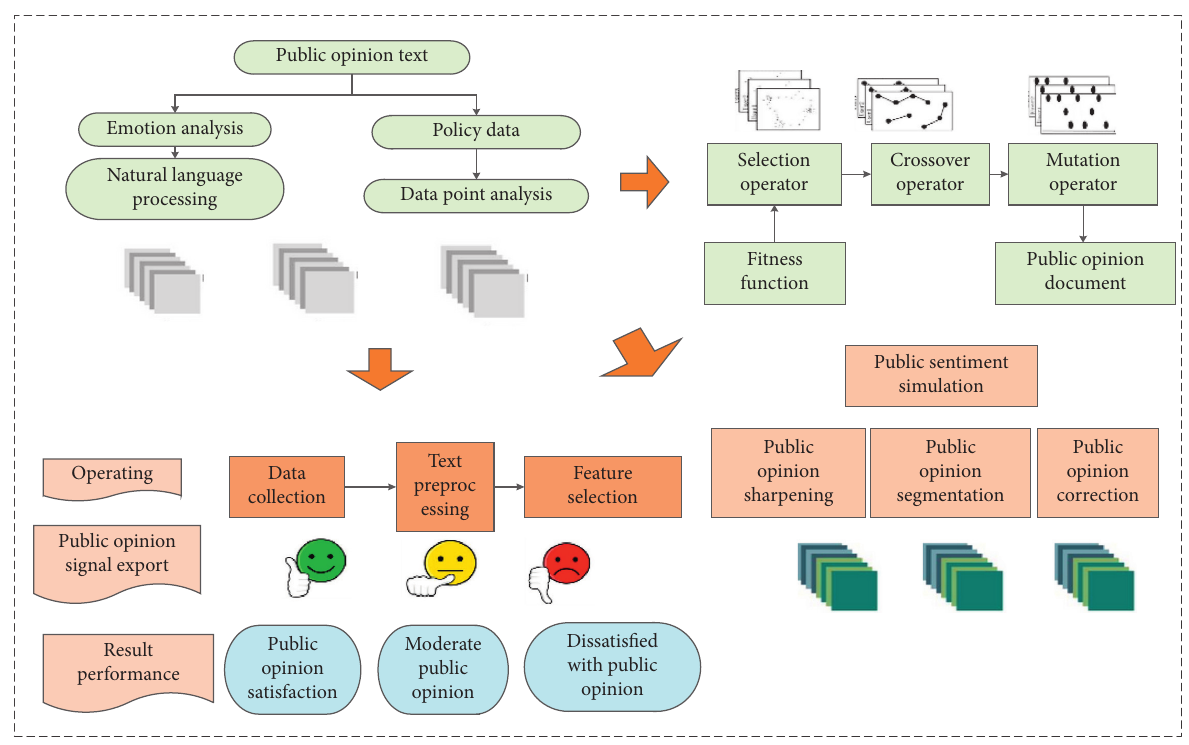
Figure 3: The framework of the public policy and public opinion system based on the Markov model.